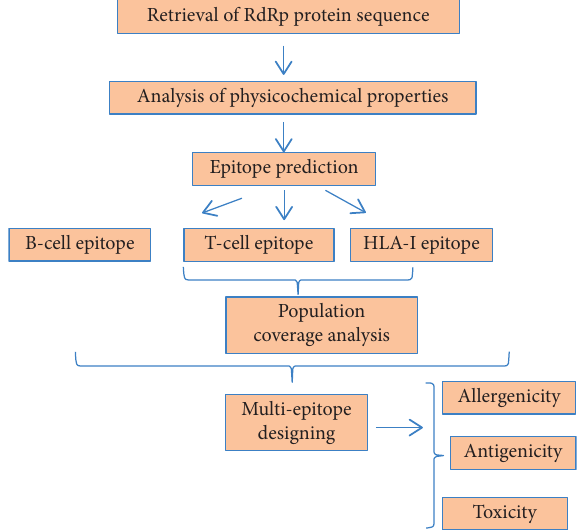
Figure 1: The workflow showing the different approaches used for epitope based peptide vaccine